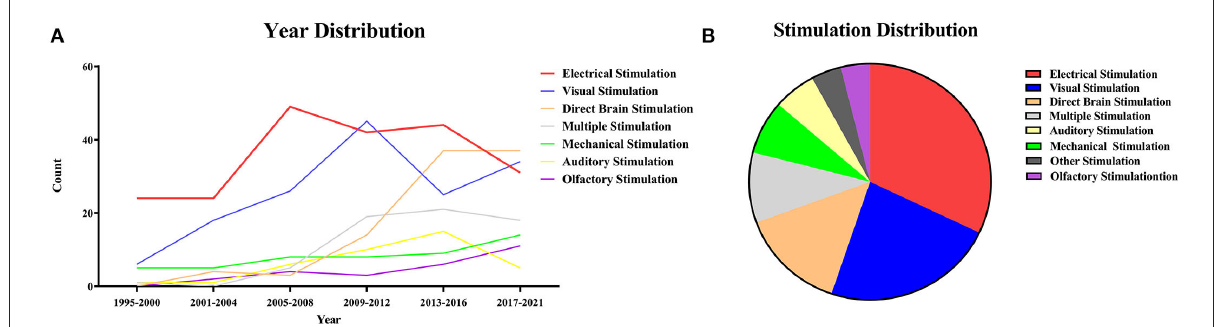
FIGURE1 (A) Year distribution of stimuli. The years of the collected articles were sorted out according to the types of stimuli and then plotted into a line graph of year distribution. The line graph can intuitively reflect the hot spots and trends of the research on stimulation combined with